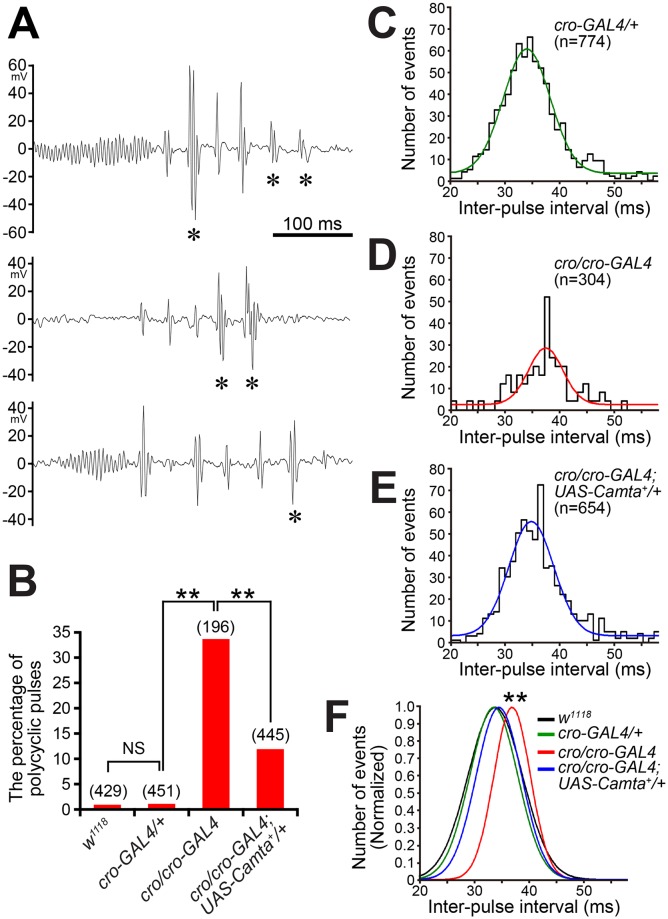
cro/cro-GAL4 mutant song defects are rescued by Camta+ overexpression.(A) Examples of courtship song records from a cro/cro-GAL4 mutant male. Three representative traces obtained from a single fly are shown. Pulses classified as polycyclic are marked with asterisks. (B) cro affects the incidence of polycyclic pulses. Males of w1118 and cro-GAL4 rarely generate polycyclic pulses, whereas more than 30% of pulses in cro/cro-GAL4 males are polycyclic. Overexpression of Camta+ rescues the mutant song phenotype. The number of pulses examined is shown in parentheses. The statistical significance of differences was evaluated by one-way ANOVA followed by Fisher’s exact probability tests; **: P<0.01. (C-F) Distribution of IPIs in the control cro-GAL4/+ (C) and cro/cro-GAL4 without (D) or with (E) the UAS-transgene that overexpresses Camta+. The Gaussian fit to the IPI distribution is drawn on each histogram, and in (F) three Gaussian curves and a control w1118 curve reproduced from Fig 1E are superimposed on the same panel to facilitate comparisons. Pulses were detected automatically as events that exceeded the slice level. In this series of experiments, the slice threshold was set at a more stringent level of 60% to avoid erroneous counts of non-song deflections due to lower signal-to-noise ratio. Even under such stringent conditions, the estimated incidence of polycyclic pulses was similar to that obtained at a slice level of 50%.